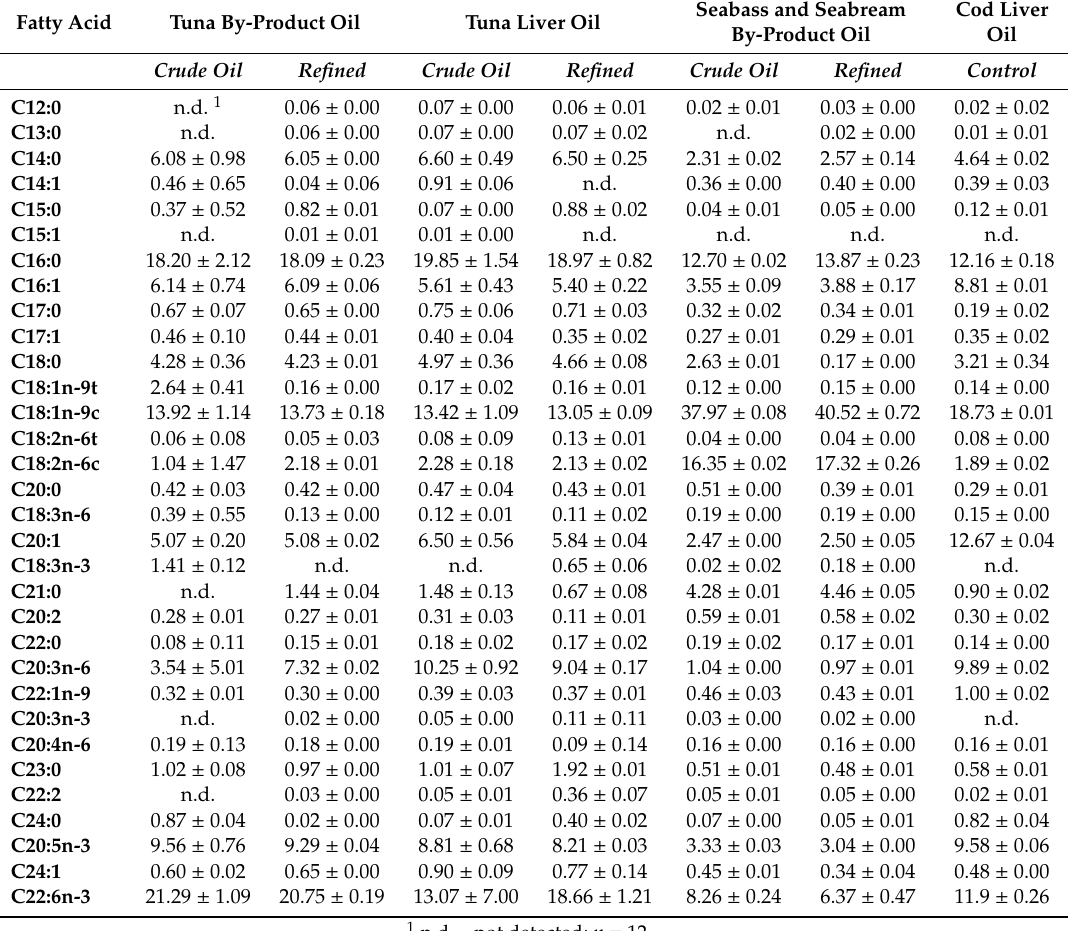
Table 2. The changes in fatty acid profile (%) of crude and refined oils from tuna by-products, tuna liver, seabass and gilthead seabream by-products and comparison to cod liver oil (control). Fatty Acid Tuna By-Product Oil Tuna Liver Oil